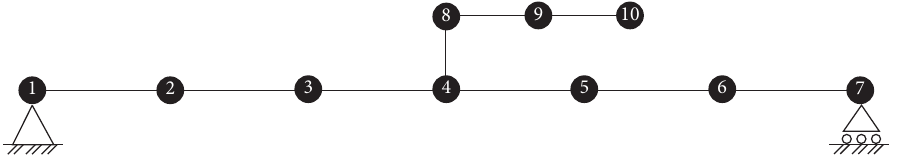
Figure 7: The FE model of the pipeline structure with the beam